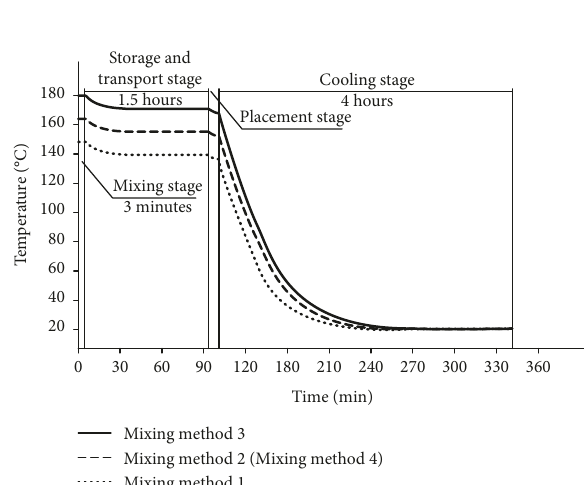
Figure 2: Thermal history of samples with different mixing